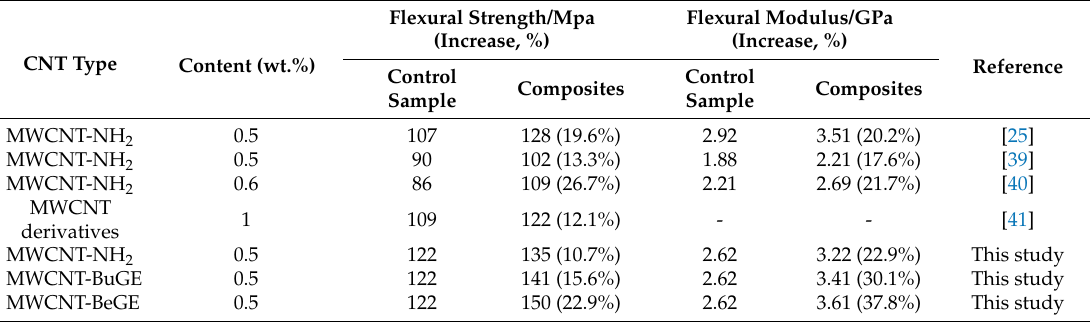
Table 2. Comparison of flexural properties between this study and other researches for